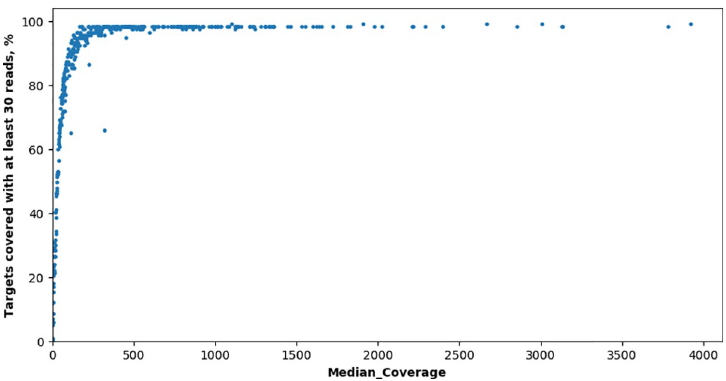
Fig 4. Percent of targets covered by at least 30 reads vs median coverage for samples sequenced for the LRRK2 gene. Each dot is a distinct DNA